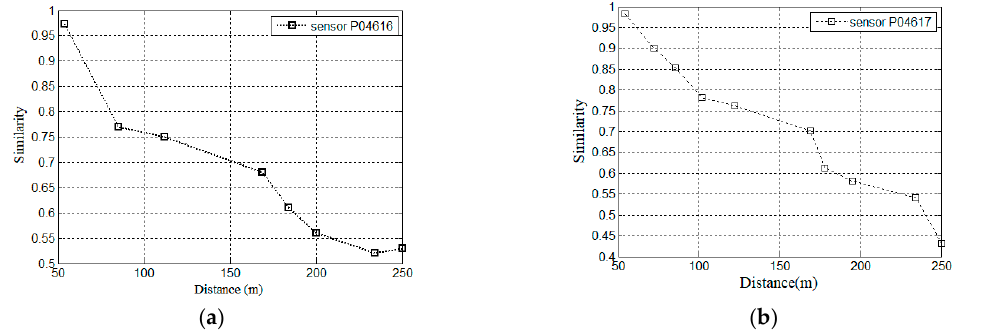
Figure 5. Spatial similarity in different sensors’ readings. ( a ) Sensor P04616; ( b ) sensor P04617.